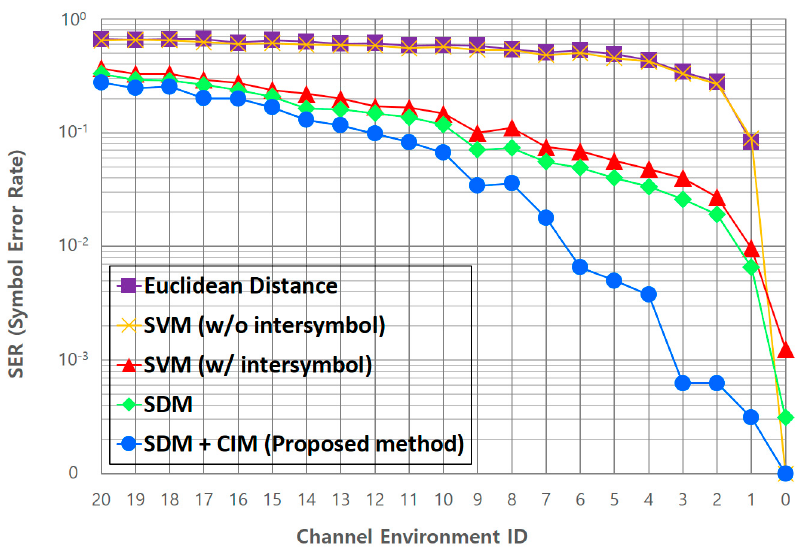
Figure 12. SER performance of the proposed adaptive symbol decision method.